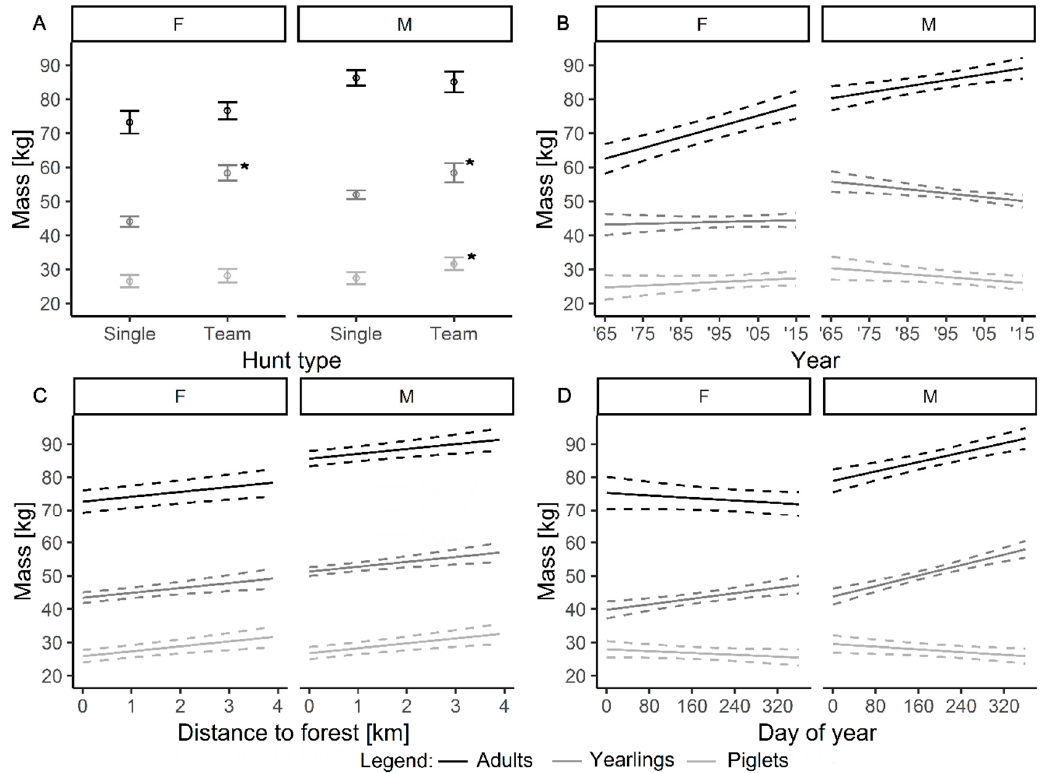
Figure 3. Prediction from the fitted model showing the relationship between different explanatory variables ( A )—term: age × sex × hunt method; ( B )—term: sex × year + age × year; ( C )—term: distance to forest; ( D )—term: age × sex × day of the year) and mass of culled wild boar ( Sus scrofa ) at the Czempi ń hunting area in western Poland. Dashed lines showed 95 confidence intervals. The asterisks in panel A show significant Tukey test comparisons between hunt types ( p < 0.001). F—females, M— males.